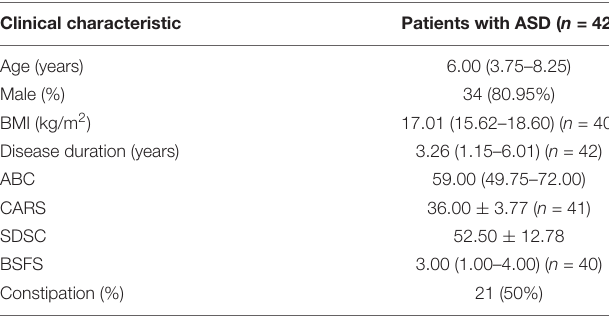
TABLE 1 | Baseline characteristics of